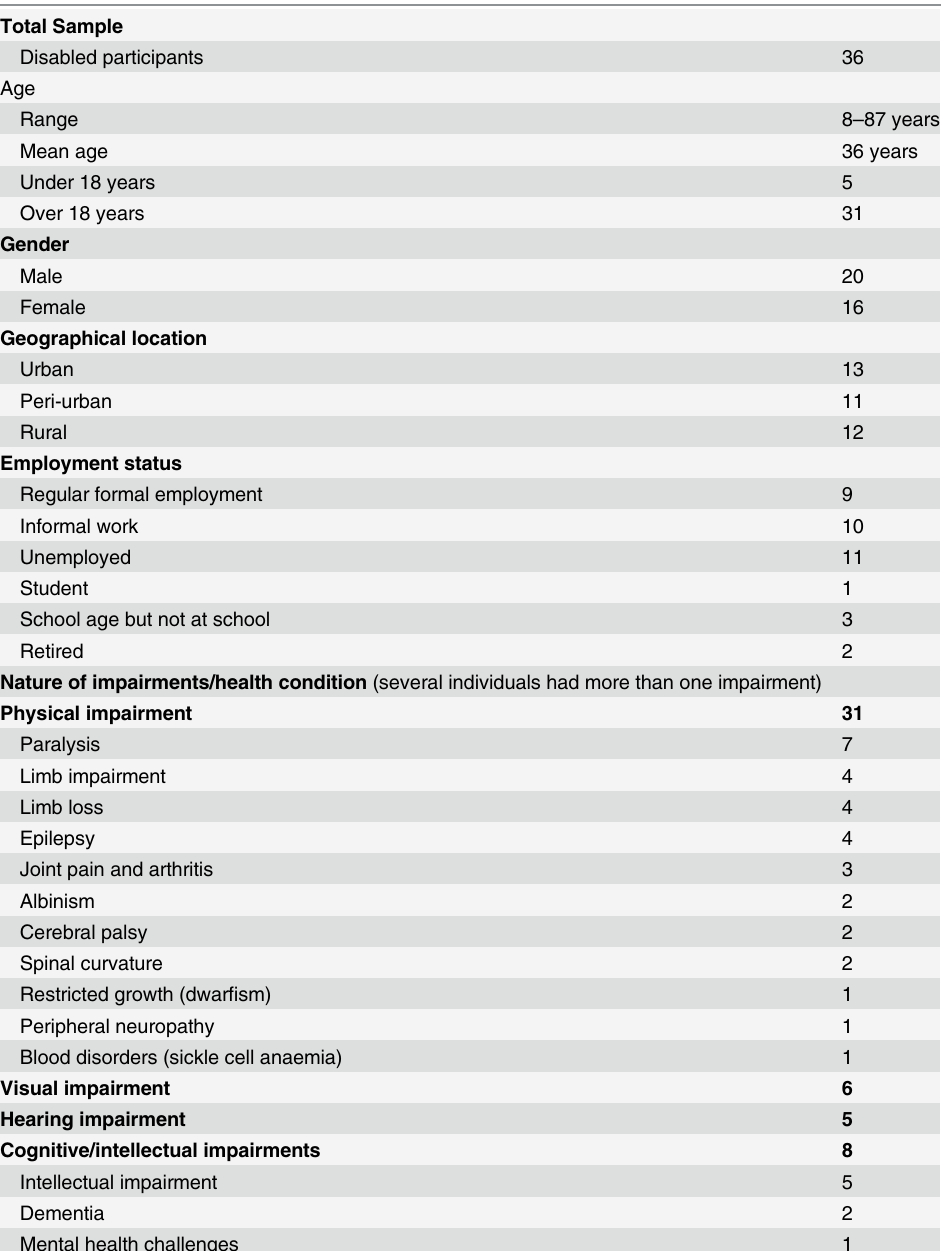
Table 3. Characteristics of